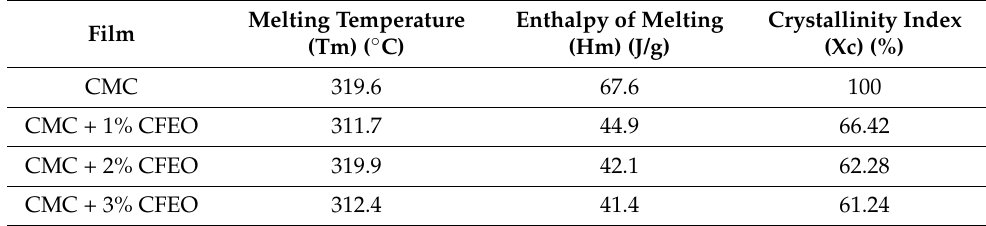
Table 4. The melting temperature (Tm), enthalpy of melting (Hm) and crystallinity index (Xc) of CMC and blended CMC-CFEO